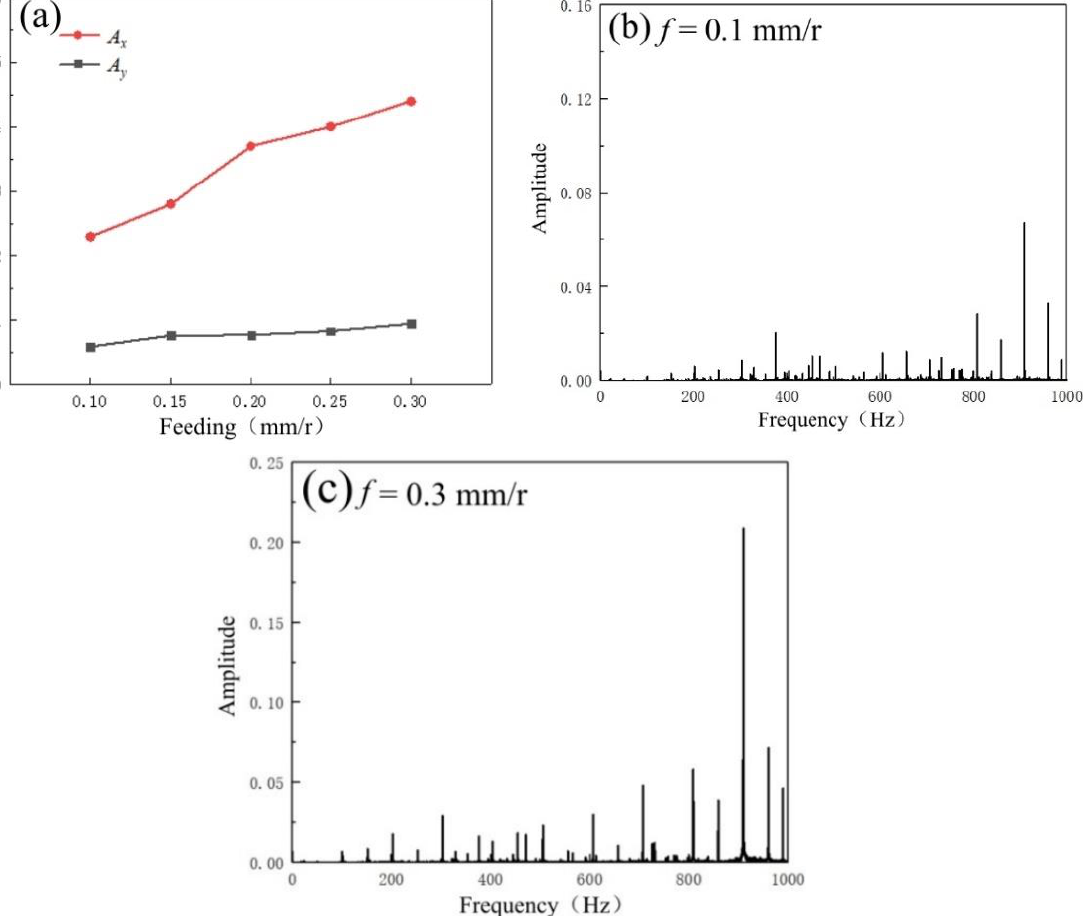
Figure 15. ( a ) Variation trends of displacement acceleration at different feed rates. The frequency domain distributions of tool-moving direction: ( b ) f = 0.1 mm/r; ( c ) f = 0.3 mm/r.